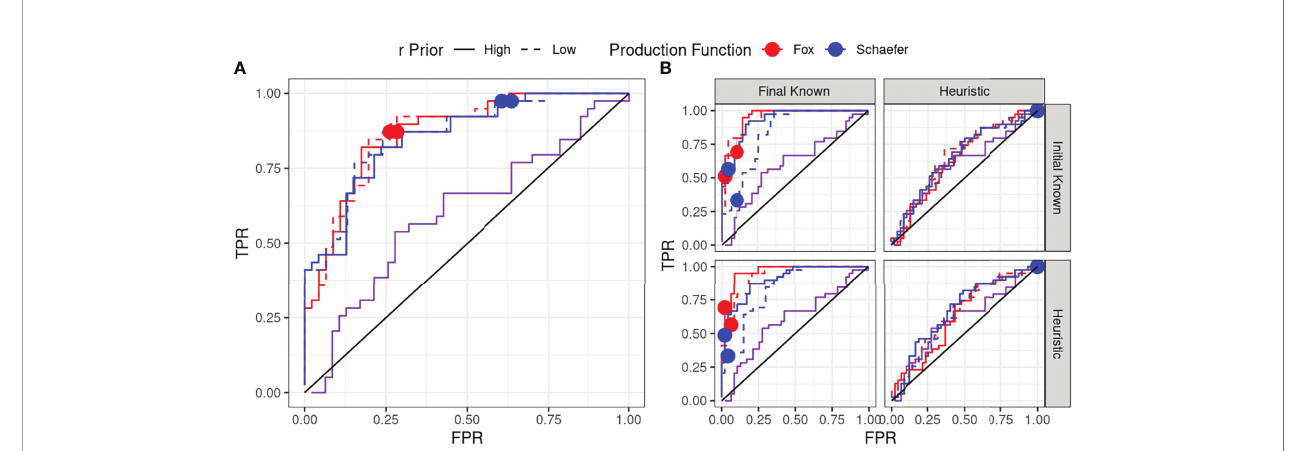
FIGURE 3 | Receiver Operator Characteristics curves for B:B MSY , The biomass dynamic assessment model with the index of abundance estimates are shown in panel (A) , and the catch-only model values in panel (B) The true positive rate (TPR) is the proportion of positive cases correctly identi fi ed and false positive rate (FPR) is the proportion of negative cases incorrectly identi fi ed as being positive. The points are for when the estimates of B:B MSY = 1. The black line ( y = x ) is equivalent to a coin toss, and the purple corresponds to the reference case where the heuristic for fi nal depletion alone was used, i.e. running the catch-only model without data. The blue and red lines are the estimates for the two production functions, and the dashed/solid lines are for the choice of r prior. The dots correspond to a discrimination threshold of B/B